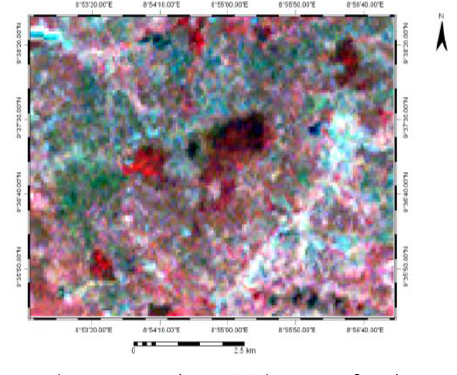
Figure. 2a-Landsat MSS imagery of study area for 1975